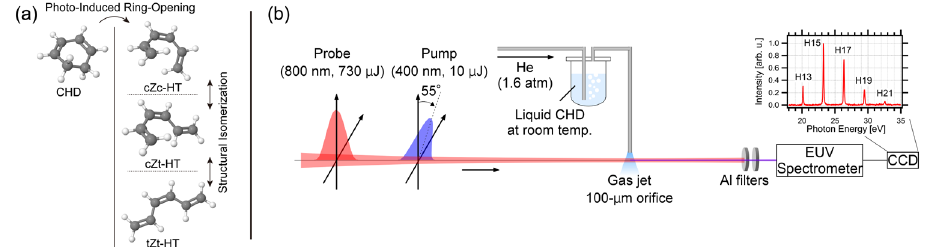
Fig. 1. (a) Three-dimensional representations of 1,3-cyclohexadiene (CHD) and its isomers. (b) Schematic of the experimental setup. Inset shows the observed harmonic